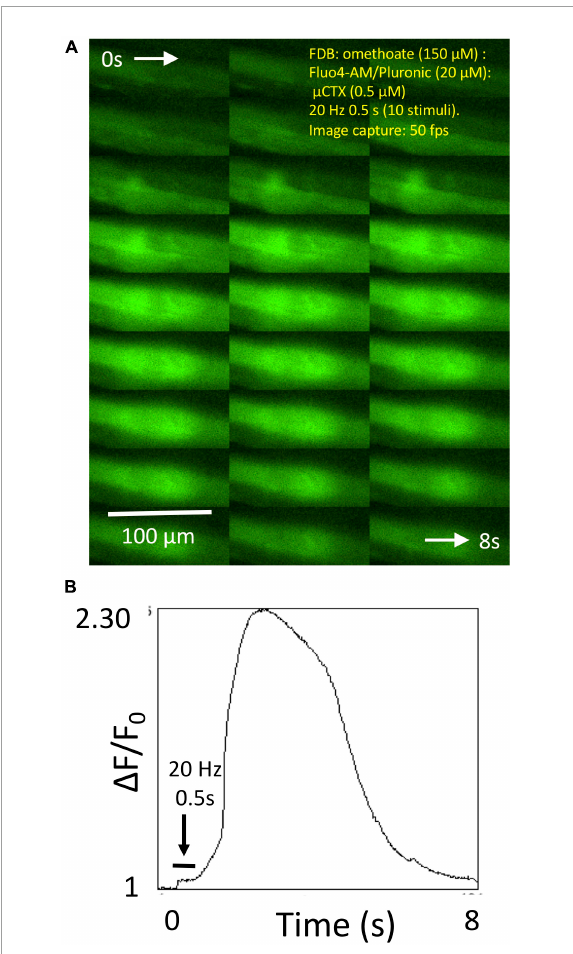
FIGURE5 Omethoate induces “calcium bombs” in some muscle fibers. (A) Montage of sequential images of the endplate region of a group of FDB muscle fibers before during and after brief (20 Hz, 0.5 s) tetanic stimulation of the tibial nerve supply. (B) Plot of relative increase in fluorescence during the image sequence shown partly in panel (A) (complete sequence in Supplementary Video 4 ). Stimulation produced a relatively small increase in fluorescence during stimulation (horizontal bar) but which continued to increase, evidently regeneratively, after cessation of the tetanic stimulus